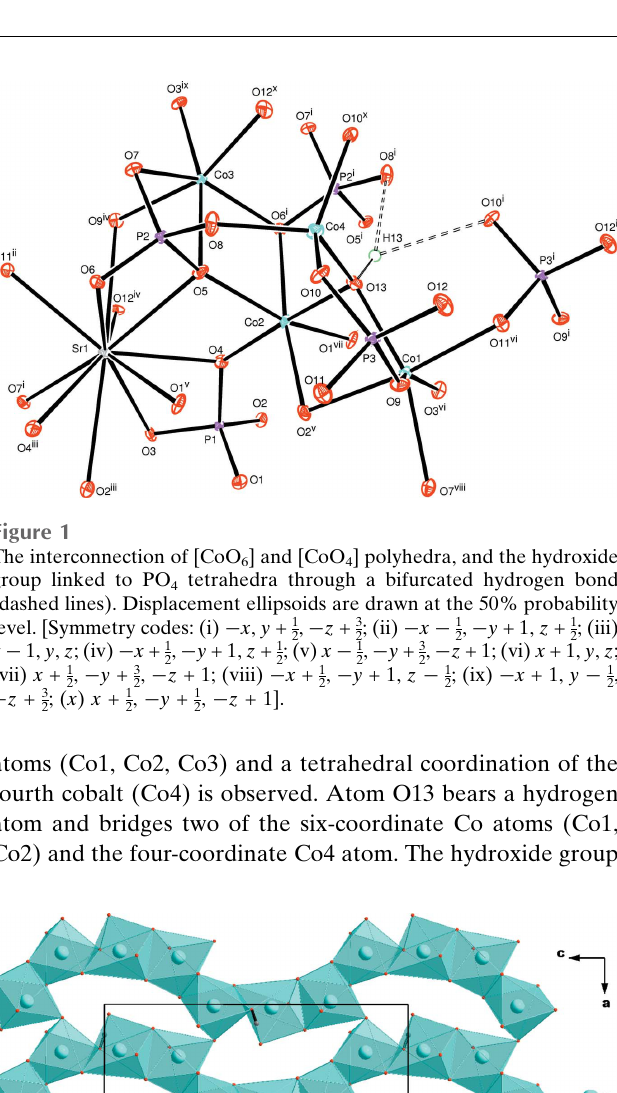
Figure 4 Ribbons formed by [CoO 4 ] and P2O 4 and P3O 4 tetrahedra, and strontium atoms and P1O 4 tetrahedra at the same height forming the second layer parallel to